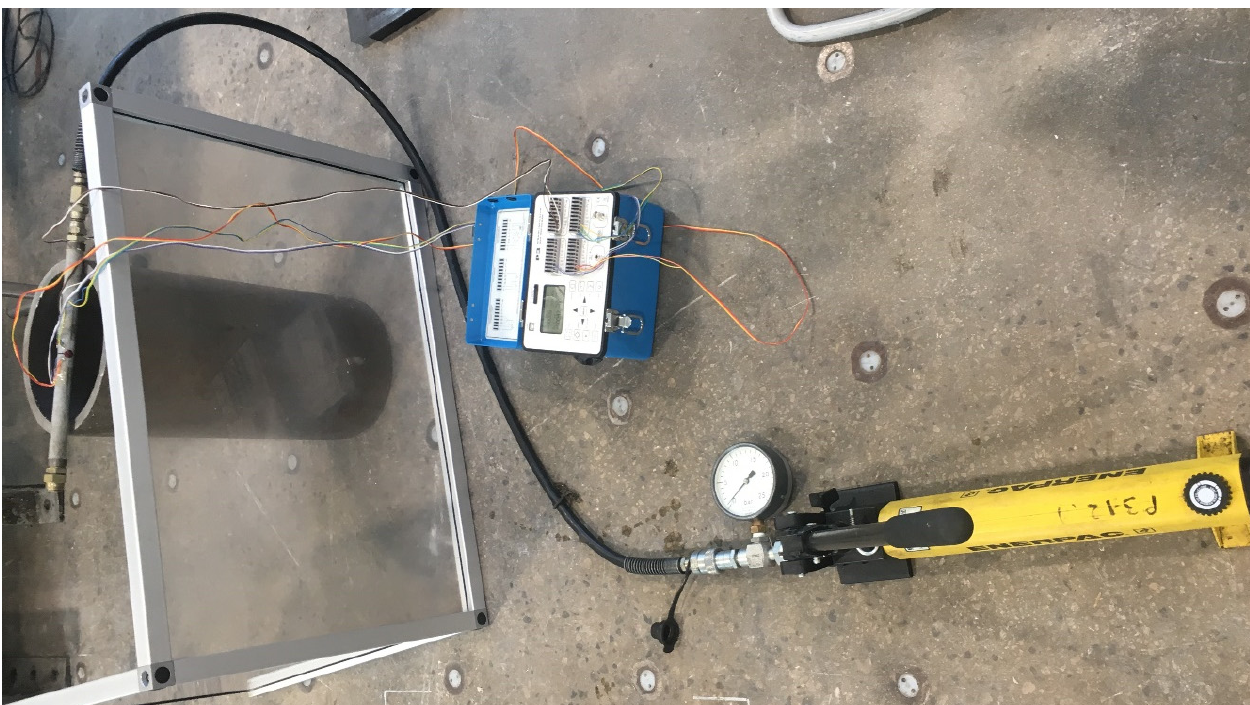
Figure 1. An experimental test showing some sensors attached to a GFRP composite pipe sample for monitoring strains under pressure loading (a test was conducted at Lancaster University Engineering Department; Image Credit: Author 1—C.V.A.).